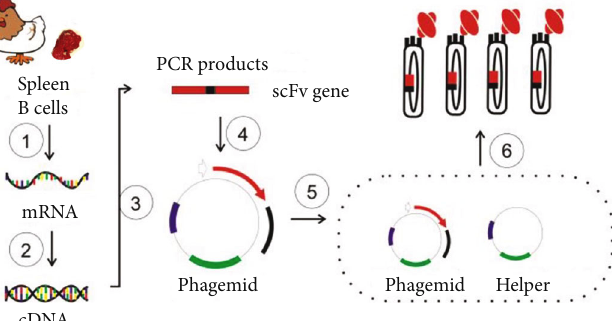
Figure 1: Schematic diagram of the construction of a large-capacity phage antibody display library: ① : mRNA isolation from hen B-cells; ② : RT-PCR; ③ : scFv assembly by overlapping PCR; ④ : ligation; ⑤ : electrotransformation; ⑥ : phage